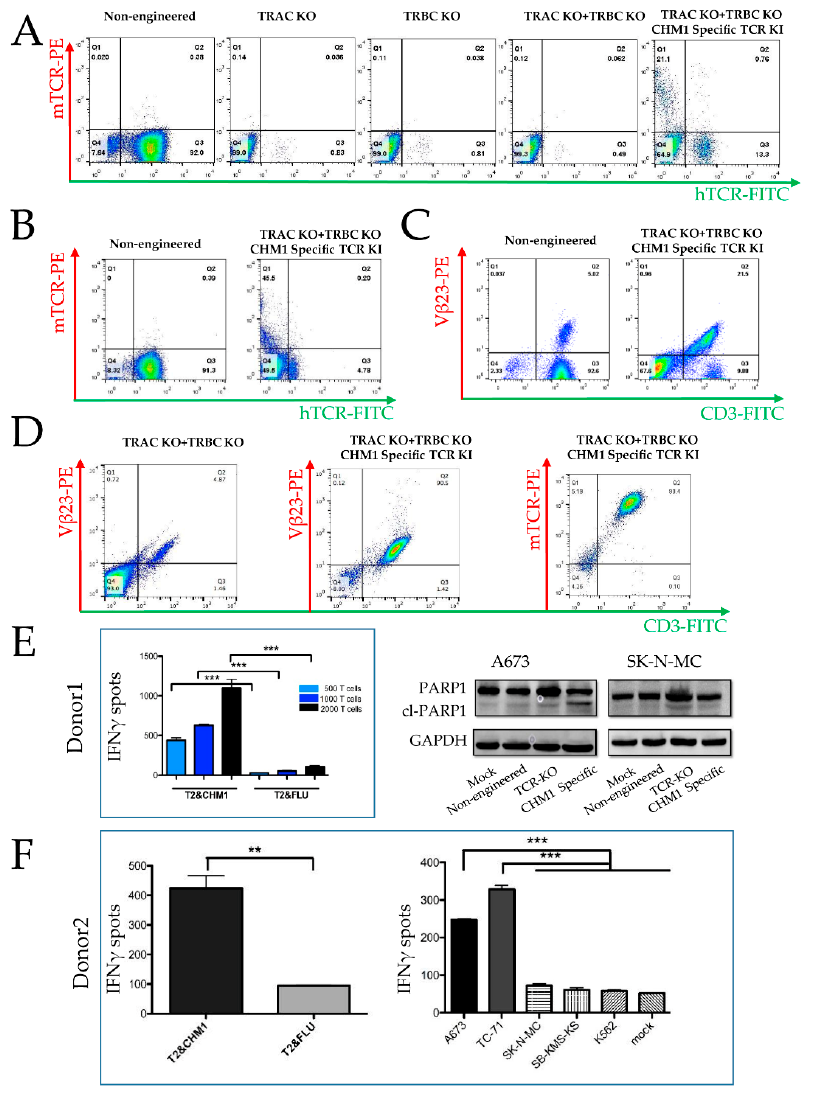
Figure 2. Feasibility of orthotopic TCR replacement by CRISPR/Cas9. ( A ) After knock-out (KO) of either α -chain (TRAC KO) or β -chain (TRBC KO) or of both chains, the endogenous TCR (hTCR) is undetectable by FACS analysis. After KO of both endogenous chains combined with knock-in (KI) of the CHM1 319 -specific TCR, mTCR is detectable (the TRBC constant chain of the CHM1 319 - specific TCR was murinized). Thawed T cells, KI efficiency: 21.3% (thawed T cells). Non-engineered: electroporation of CRISPR/Cas9 but without guide RNA. ( B ) KO of both chains combined with transgenic TCR knock-in: mTCR positive T cells are hTCR negative. Fresh T cells, KI efficiency: 45.5%. ( C ) Pentamer staining confirms transgenic TCR expression as panel B. ( D ) CHM1 319 -TCR expression in the final product of CHM1 319 -TCR insertion after enrichment. ( E ) Donor 1: IFN γ release with dose-dependent manner (500, 1000, and 2000) of transgenic T cells after exposure to T2 cells loaded with either CHM1 319 -peptide or with control-peptide (FLU) for 20 h in donor 1; PARP cleavage (cl-PARP) analyzed by SDS-PAGE after co-culture of A673 (HLA-A*0201+) or SK-N-MC (HLA-A*0201-) with either no T cells (Mock), non-engineered T cells with TCR-KO, or T cells with